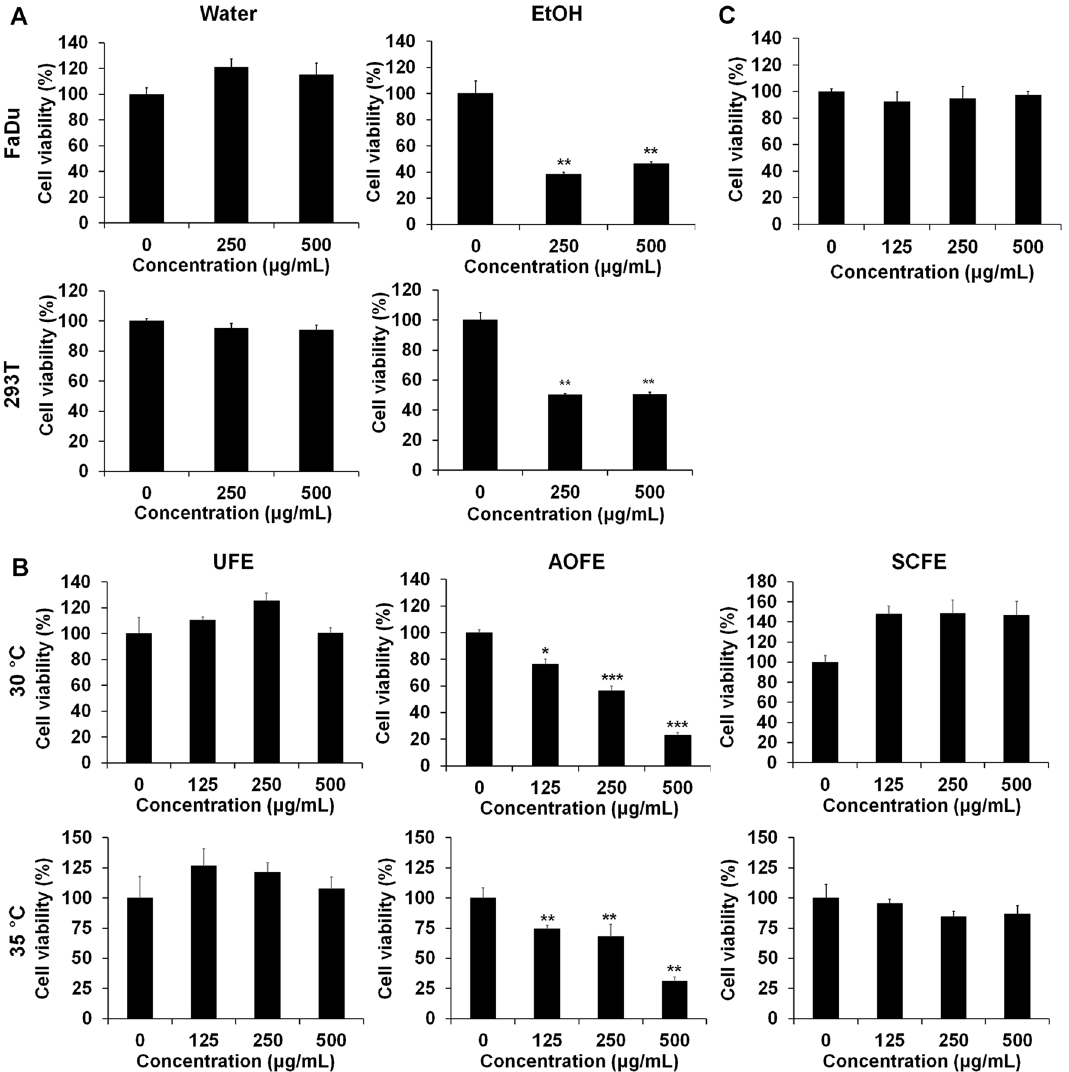
Figure 1. The effects of AOFE on the cell viability of head and neck cancer cells. ( A ) Head and neck cancer cells (FaDu) and normal cells (293 T) were plated and treated with water and EtOH extracts. ( B ) Powder of dried CJ pericarp was fermented at 30 °C or 35 °C for 3 days with A. oryzae (AOFE) and S. cerevisiae (SCFE). Fermented products were filtered and lyophilized and then treated to the cells. ( C ) The extract fermented at 30 °C with A. oryzae was treated with 293 T normal cells. Cell viability was measured by MTT assay. All data are presented as the mean ± SD. Statistical analyses were performed using paired t-test. *p < 0.05, **p < 0.01, ***p <